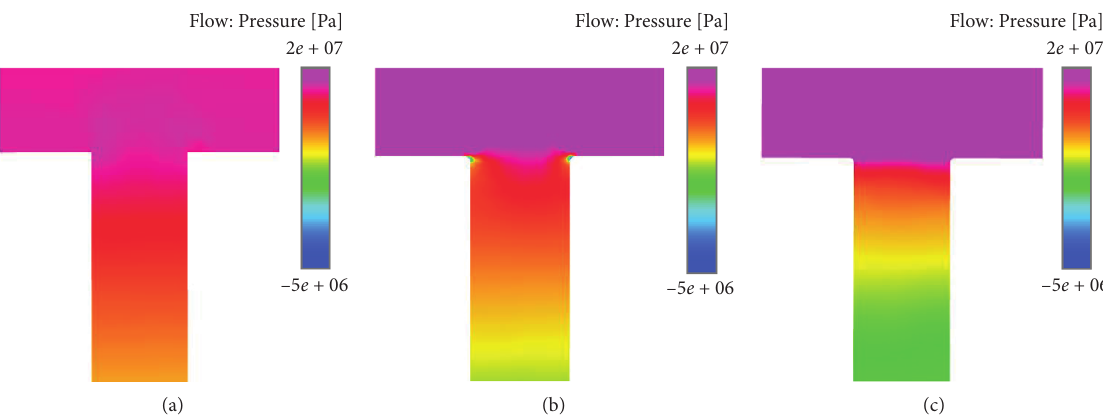
Figure 25: Pressure distribution near damping hole under stable condition. (a) Without chamfer. (b) 45-degree chamfer. (c) Arc